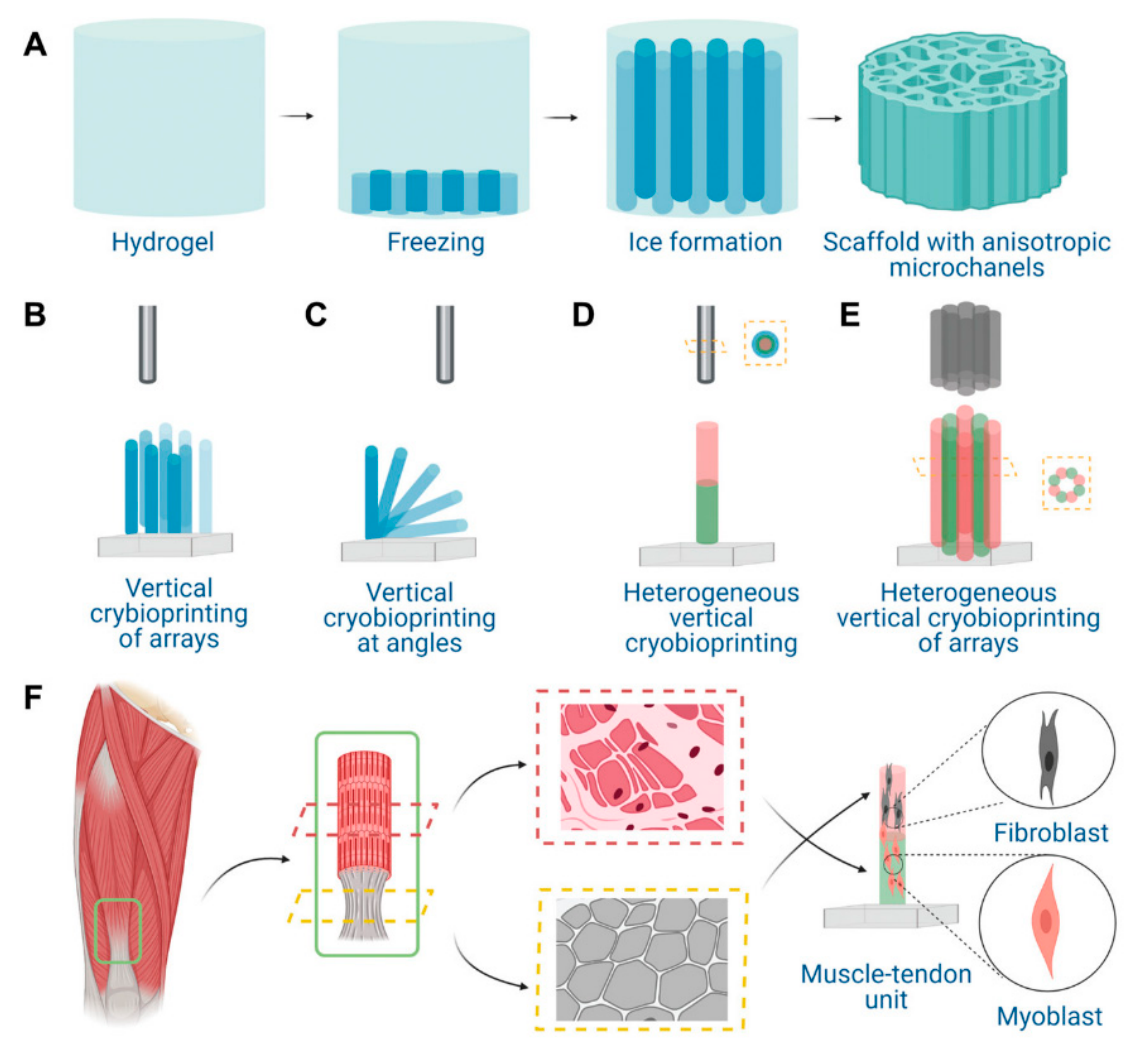
Figure 8. Schematic illustrations of vertical 3D cryo(bio)printing and its application in muscular tissue engineering. ( A ) The GelMA-based hydrogel, when subjected to directional freezing, forms interconnected gradient of anisotropic microchannels along the vertical axis. ( B ) Vertical 3D cryo(bio)printing of hydrogel filament arrays. ( C ) Vertical 3D cryo(bio)printing of hydrogel fila- ments of different angles. ( D ) Multimaterial vertical 3D cryo(bio)printing of a single hydrogel fila- ment. ( E ) Multimaterial vertical 3D cryo(bio)printing of hydrogel filament array. ( F ) Vertical 3D cryo-bioprinting for fabricating the muscle-tendon unit. Reprinted with permission from [123] , Copyright 2021, Wiley. Table 2. Anisotropic macroporous hydrogels in tissue engineering.